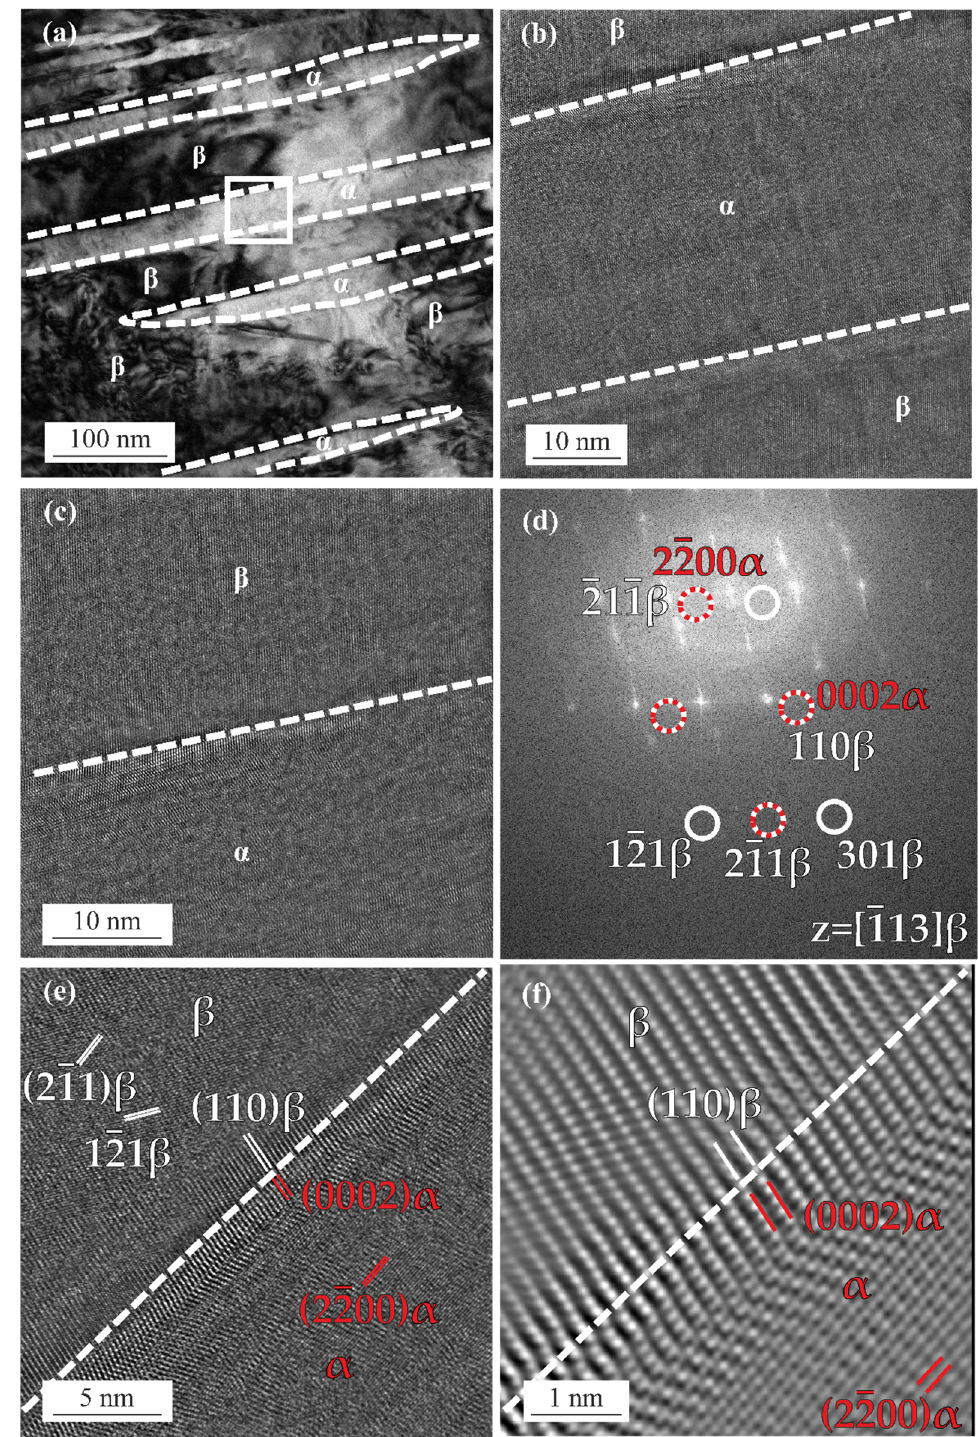
Figure 7. ( a ) TEM image of α phase and β phase in the ST+FC specimen; ( b ) HRTEM image of the α lath and β phase; ( c ) HRTEM image of the upper α / β interface in ( b ); ( d ) FFT image of the area in ( c ) with [113] β zone axis; ( e ) magnified HRTEM image of the α / β interface in ( c ) with the (2 1(cid:3364) 1) β , (1 2(cid:3364) 1) β , (110) β , (0002) α , and (2 2 (cid:3364) 00) α planes marked; ( f ) Fourier filtered HRTEM image showing the α / β interface in ( e ) with the (110) β , (0002) α , and (2 2(cid:3364) 00) α planes marked. Metastable β titanium alloys tend to decompose to the ω , α , and α″ phases. The ω phase probably occurs at lower temperatures, as described by Ohmori et al. [82]. In the as-built condition, the ω phase was not observed during TEM investigations, but, due to